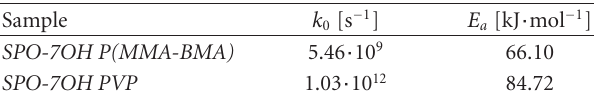
Table 3: Activation energy ( E a ) and the Arrhenius preexponential factor ( k 0 ) for thermal relaxation process of SPO-7OH in polymer